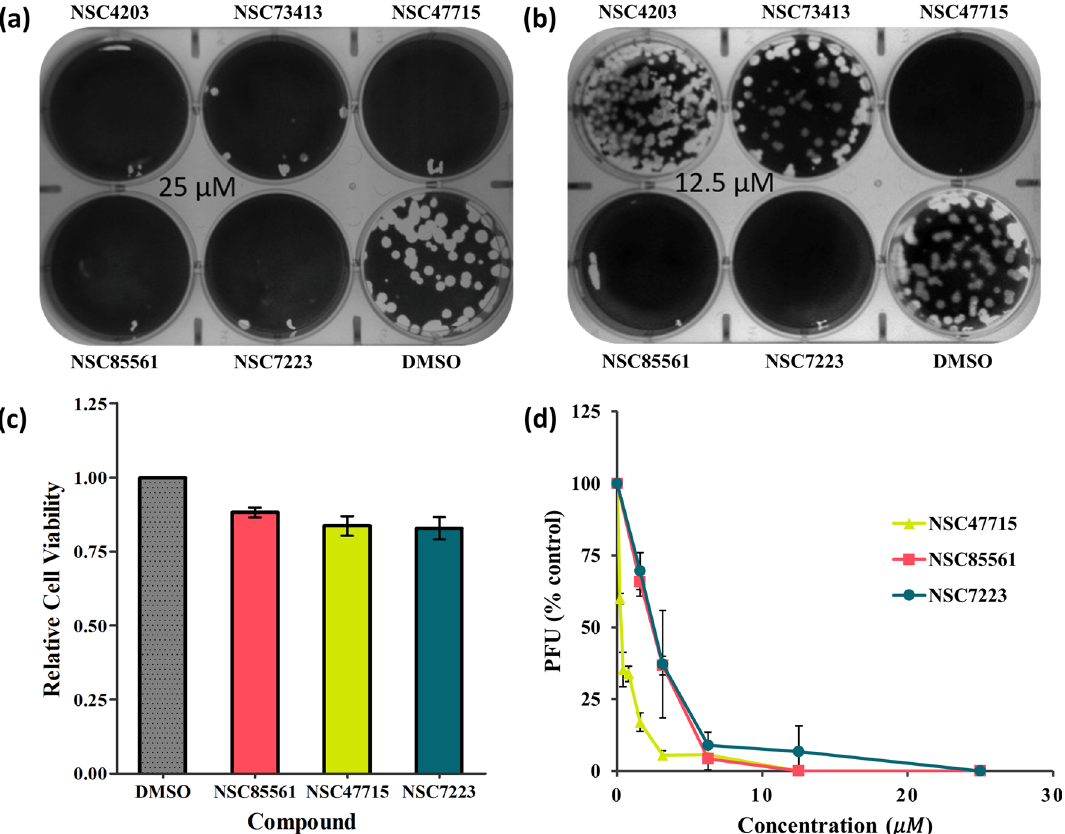
Figure 5. Identification of NSC47715, NSC85561 and NSC7223. MDCK cells were infected with A/WSN/1933 (H1N1, 100 PFU) and mixed with the five compounds at (a) 25 µM and (b) 12.5 µM. A virus plaque reduction assay was performed. (c) Relative cell viability value for NSC47715, NSC85561 and NSC7223 were evaluated by the MTS assay. (d) MDCK cells infected with the H1N1 virus were mixed with the three compounds in two-fold serial diluted concentrations. The plaque reduction assay was performed in at least three independent experiments.